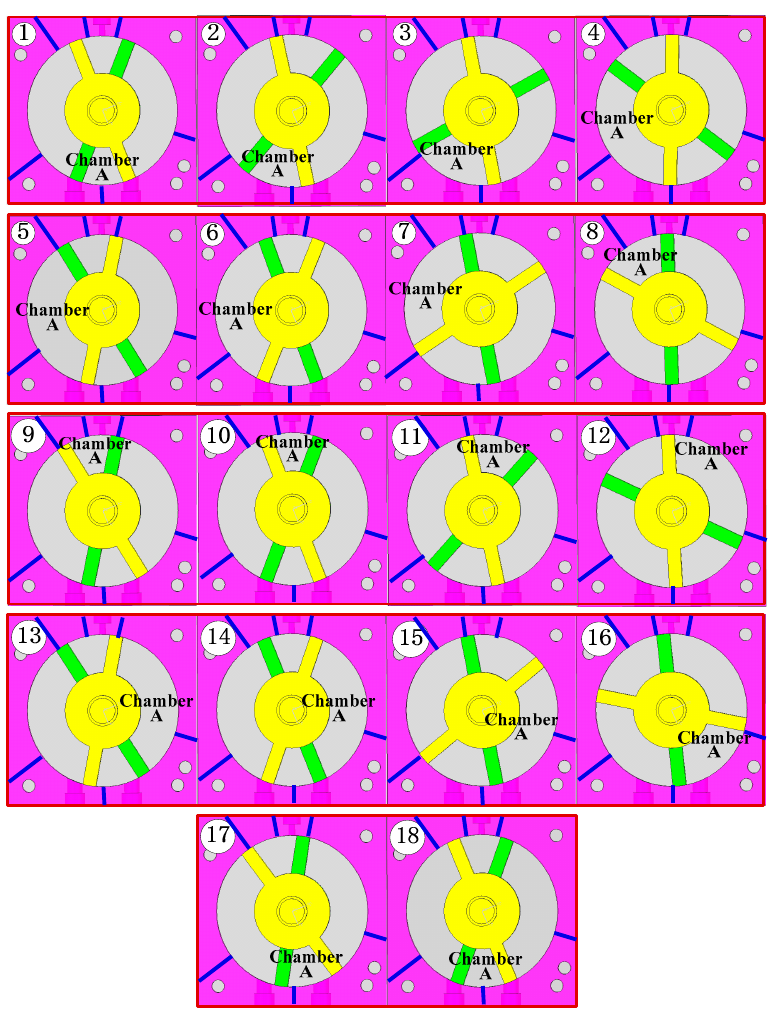
Figure 28. Selection principle of the six measuring points.